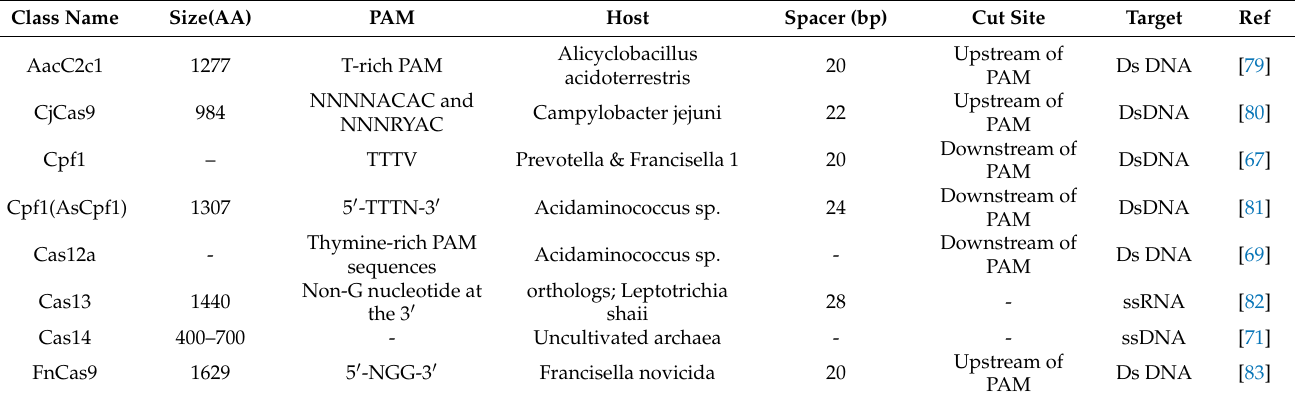
Table 2. Different newly emerged CRISPR/Cas techniques with potential functions in associated